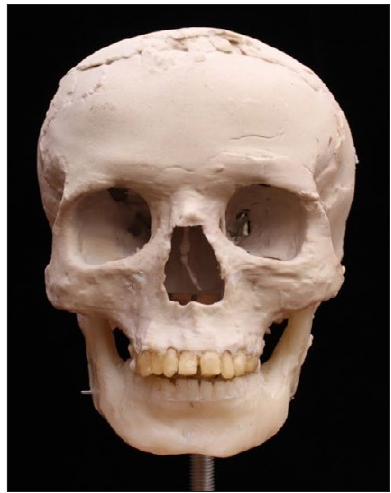
Figure 3: The 3D print of the Jericho Skull crania, showing the facial features includ- ing a model mandible, added to the cra- nia for the purposes of reconstruction (© Trustees of the British Museum, photo by RN-DS partnership).